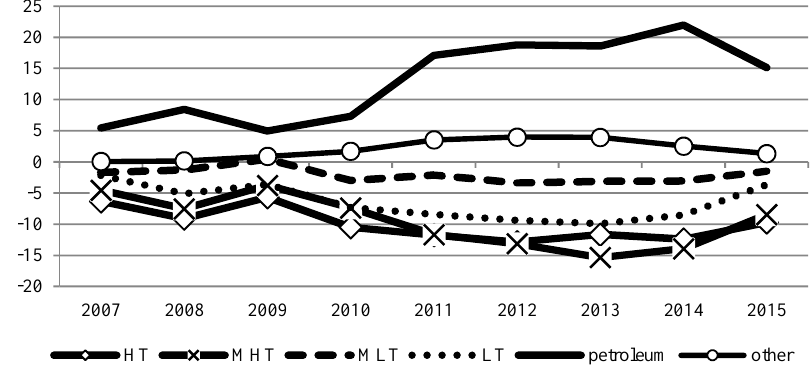
Source: own elaboration based on United Nations Commodity Trade Statistics